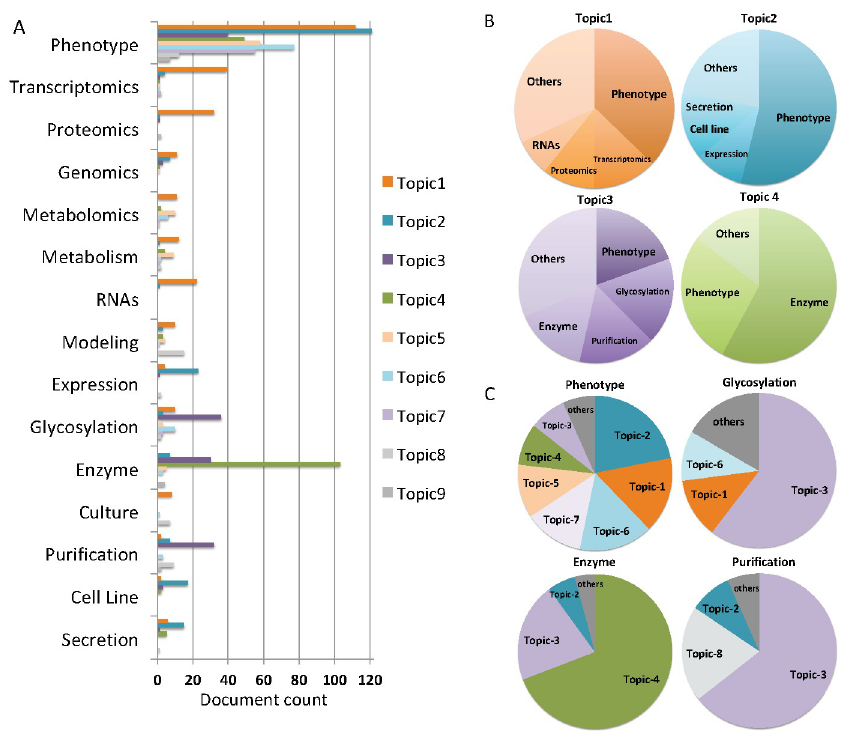
Fig 3. Comparison between automatically generated LDA topics and manually assigned categories. (A) Distribution of human-annotated categories among computer-generated LDA topics. (B) Distribution of the top four LDA topics in manual categories. (C) Distribution of the top four manual categories in LDA topics.